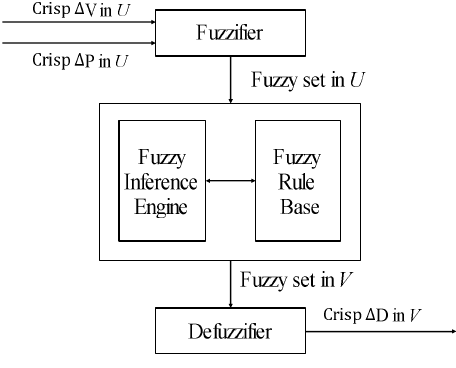
Figure 5. Fuzzy logic controller model.